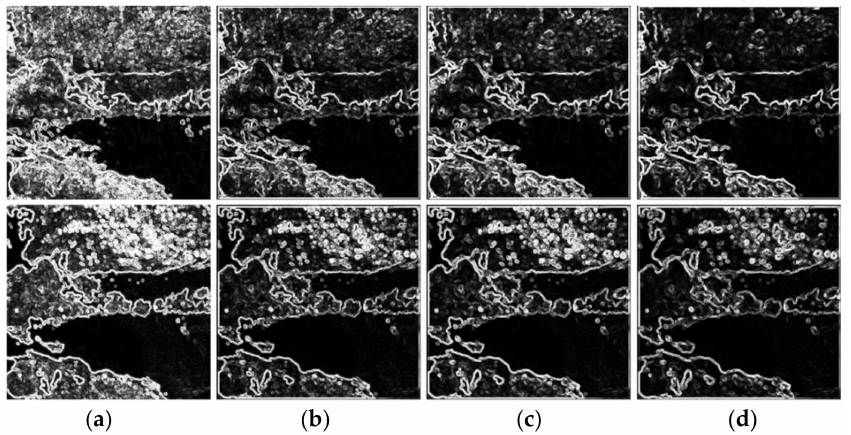
Figure 3. Results of new gradient magnitude: ( a ) The gradient amplitude of the original image pair; ( b ) The gradient amplitude of the image pair in first layer scale space; ( c ) The gradient amplitude of the image pair in second layer scale space; ( d ) The gradient amplitude of the image pair in third layer scale space.